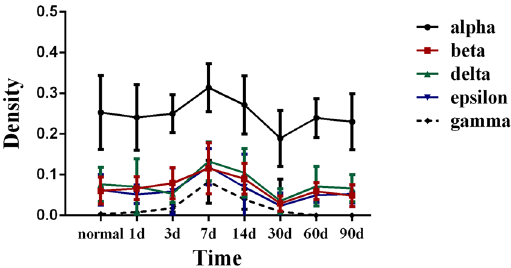
Figure 7. Optical density of α , β , δ , ε , and γ subunits at the NMJs in the DIV (grade IV) facial nerve injury group. All values are means ± standard deviation.